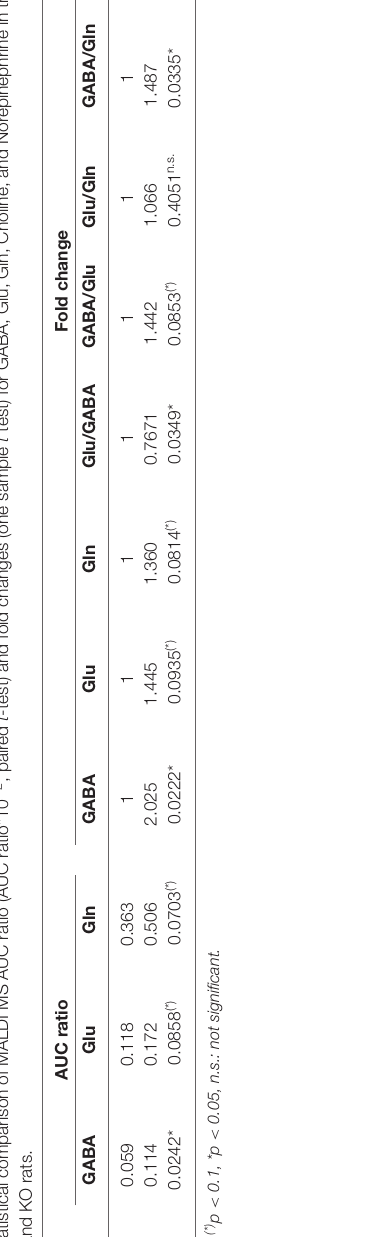
The relationship between startle pulse intensities and ASR magnitudes can be altered through a number of variables, such s .: as the genotype and pharmaceuticals ( Figure 2 ; for review, see n . 05 , Koch, 1999). We next aimed to test if R-Baclofen could decrease the enhanced ASR magnitudes and ASR capacity in Cntnap2 KO rats. We first compared the effects of R-Baclofen on the ASR I-O function and maximal response magnitudes within genotype and sex ( Figure 6 ). In Cntnap2 WT rats, all three doses of R-Baclofen (0.75, 1.5, 3 mg/kg) significantly decreased the ASR magnitudes to startle pulses of increasing intensity compared with saline in both females and males ( Figure 6A Left, Cntnap2 WT F: n = 6, Two-way RM ANOVA, intensity p < 0.0001, F (10,55) =